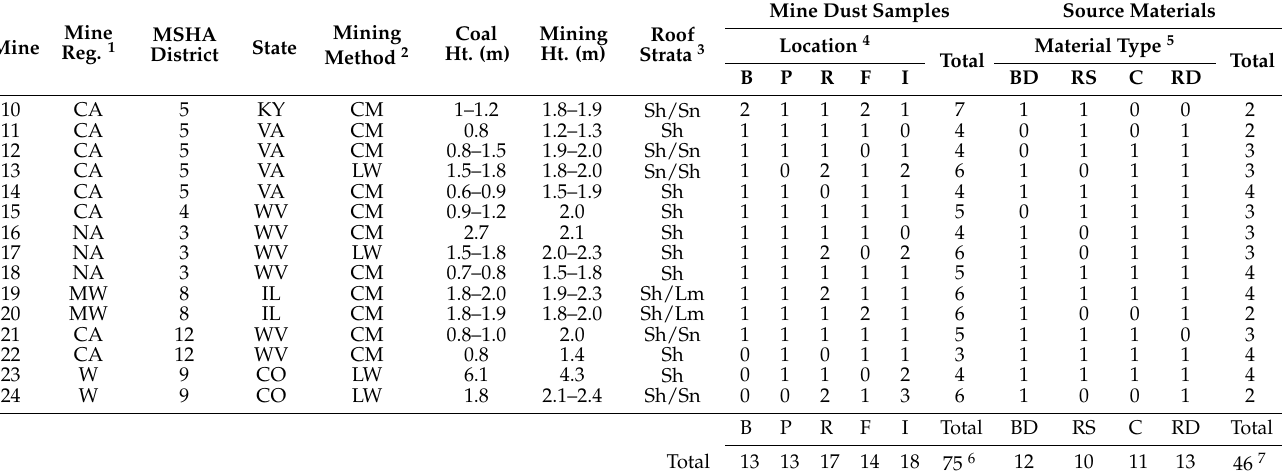
Table 1. Summary of available RCMD and source material samples from 15 underground coal